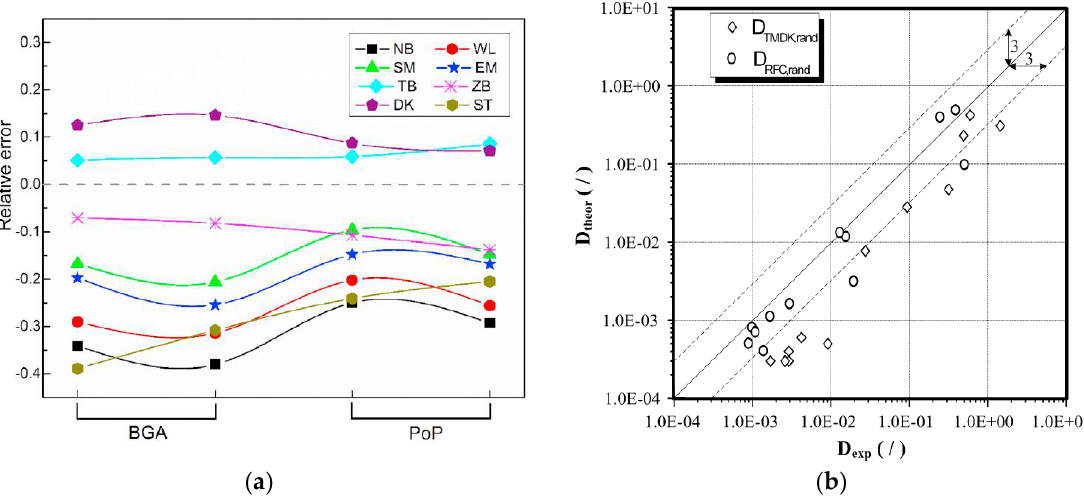
Figure 10. Comparison with experimental data: ( a ) electronic application for package-on-package (PoP) and ball grid array (BGA) (DK = Dirlik, TB = TB method, ZB = Zhao-Baker, SM = single-moment, ST = Steinberg method, WL = Wirsching-Light) ( b ) temperature effect on random loading (D TMDK = temperature modified Dirlik method). Reproduced from [30,62] with permission from Elsevier.